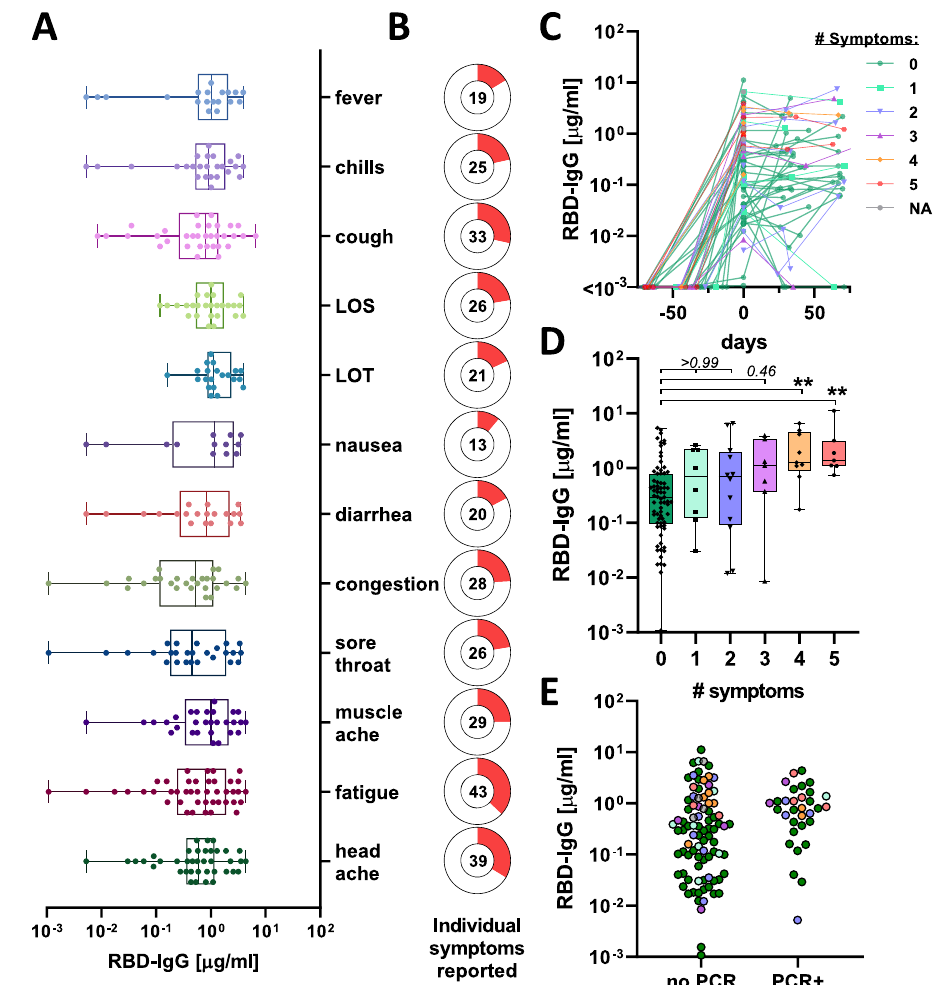
Fig. 1 SARS-CoV-2 titer heterogeneity by symptoms. A IgG-RBD titer by reported symptom (values for individuals with multiple symptoms are shown for each symptom individually; LOS loss of smell, LOT loss of taste) (box extends from 25th to 75th percentile, whiskers show min and max, and vertical line indicates the median). B Donut plots with the proportion of individuals who reported the individual symptom in ( A ), the number in the donut hole indicates the absolute number of individuals (from a total of 116 individuals with symptom data). C The line plot shows the trajectory of SARS-CoV-2 RBD-speci fi c antibody titers following seroconversion in 120 individuals (colors and symbols indicate the number of reported symptoms). D The whisker box plots show study maximum observed RBD titers grouped by individuals reporting 0 – 5 symptoms (box extends from 25th to 75th percentile, whiskers show min and max, and the horizontal line indicates the median; n 0 = 73, n 1 = 8, n 2 = 12, n 3 = 7, n 4 = 9, n 5 = 7). E The dot plot shows RBD-speci fi c IgG titers in individuals that tested PCR + ( n = 32) prior to developing antibody responses or that did not have a PCR test at the time or within 2 weeks prior to seroconversion ( n = 88; colors indicate the number of reported symptoms as in ( C ) and ( D )). Statistical differences in ( D ) were assessed with the Kruskal – Wallis test followed by a post hoc Dunn ’ s correction for multiple testing. Source data are provided as a Source Data fi